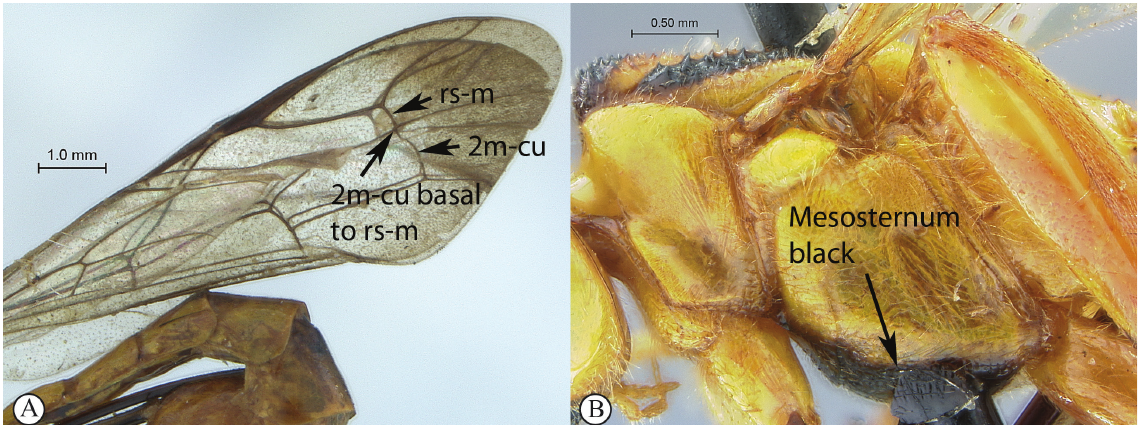
1010. Fore wing with 2m–cu basal to rs–m (A); mesosternum black (B) ……… E. leroyi Benoit, 1951